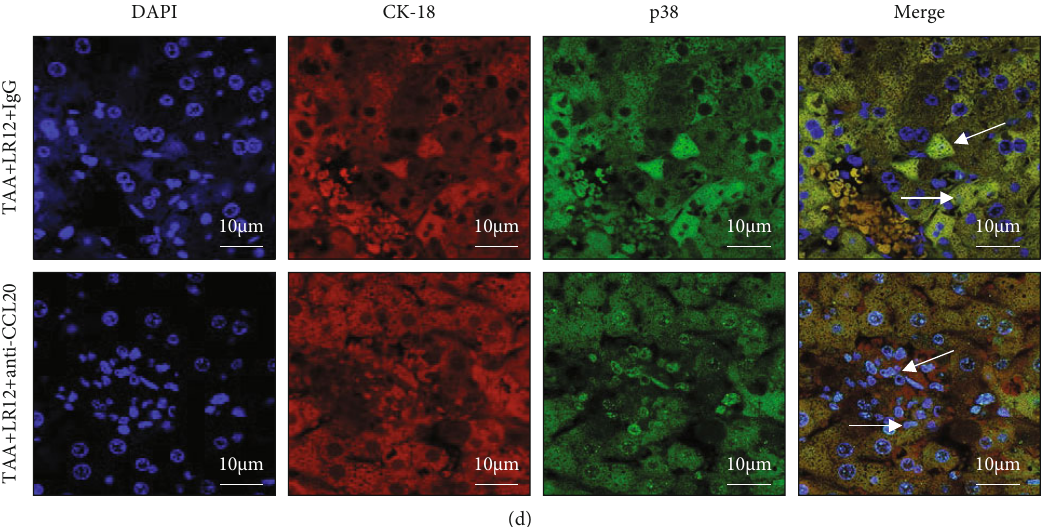
Figure 7: LR12 activated the p38 MAPK pathway by promoting the secretion of CCL20 from macrophages. (a) Western blot analysis of p-p38 in LO2 cells stimulated with the supernatant from macrophages. (b) Western blot analysis of p-p38 in primary hepatocytes. (c) Western blot analysis of p-p38 in LO2 cells stimulated with TAA+LR12 or/and anti-CCL20 hAbs. (d) CLSM showing CK18 and p38 staining in the liver tissues. Data were presented as the mean ± standard deviation (SD). ∗ P < 0 : 05 , ∗∗ P < 0 : 01 , and ∗∗∗ P < 0 : 001 versus control group.